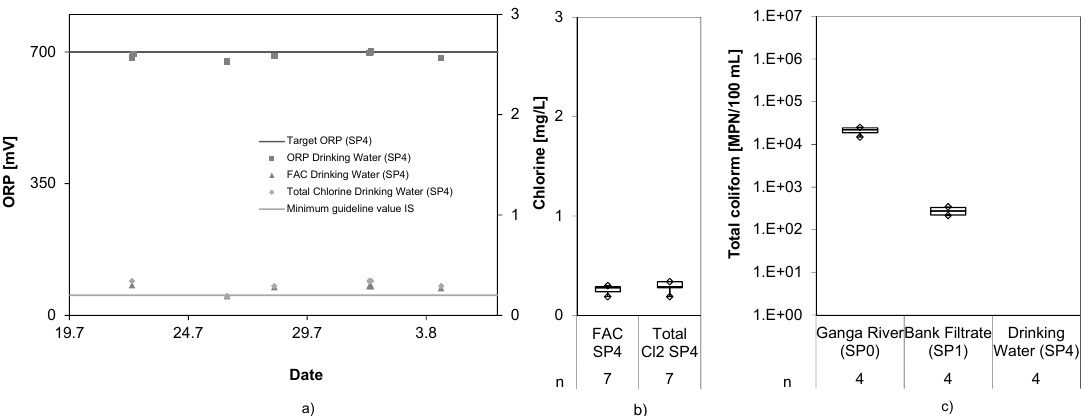
Figure 12. ORP and chlorine concentration in SP4 ( a , b ); and pathogenic contamination in short term test with optimized system setting ( c ).